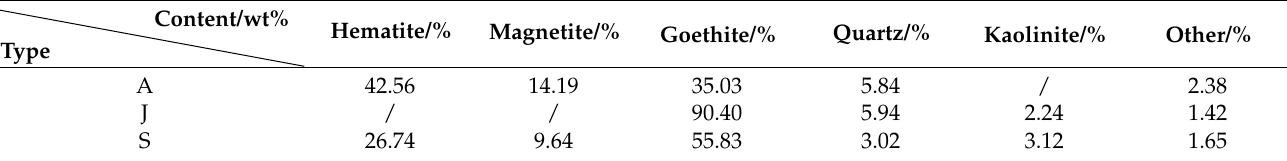
Figure 3. Microstructure and main physical phases of lump J ( a – e ). Table 5. EDS analysis results for areas in Figure 3. Table 3. The main mineral composition of the three lump